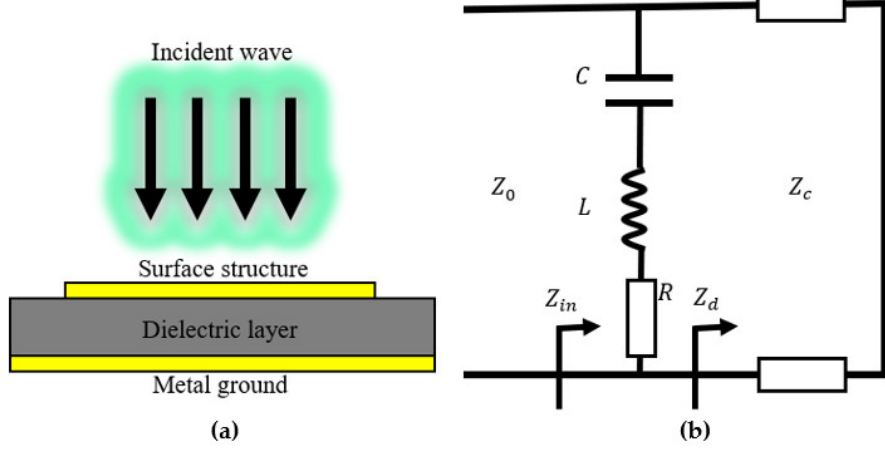
Figure 1. The model of the traditional metamaterial absorber ( a ) and the equivalent circuit ( b ).